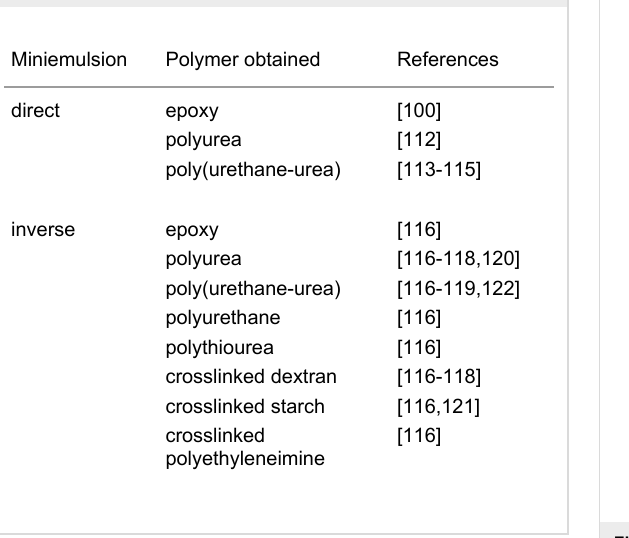
Table 6: Polymer obtained by interfacial polyaddition in miniemulsion.